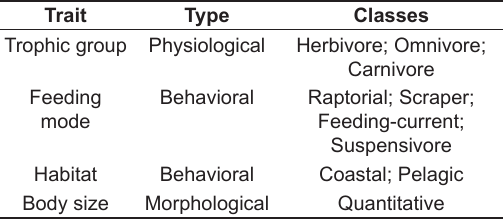
Table 1. Zooplankton functional traits, type of trait and their respective classes used to calculate the functional